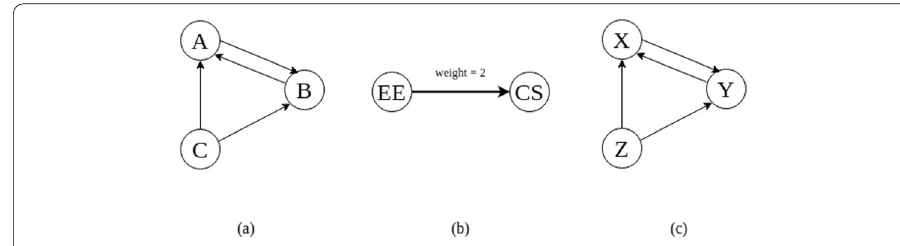
Fig. 1 Networks based on the dataset in Table 2: a MACN, b FIN, c AIN